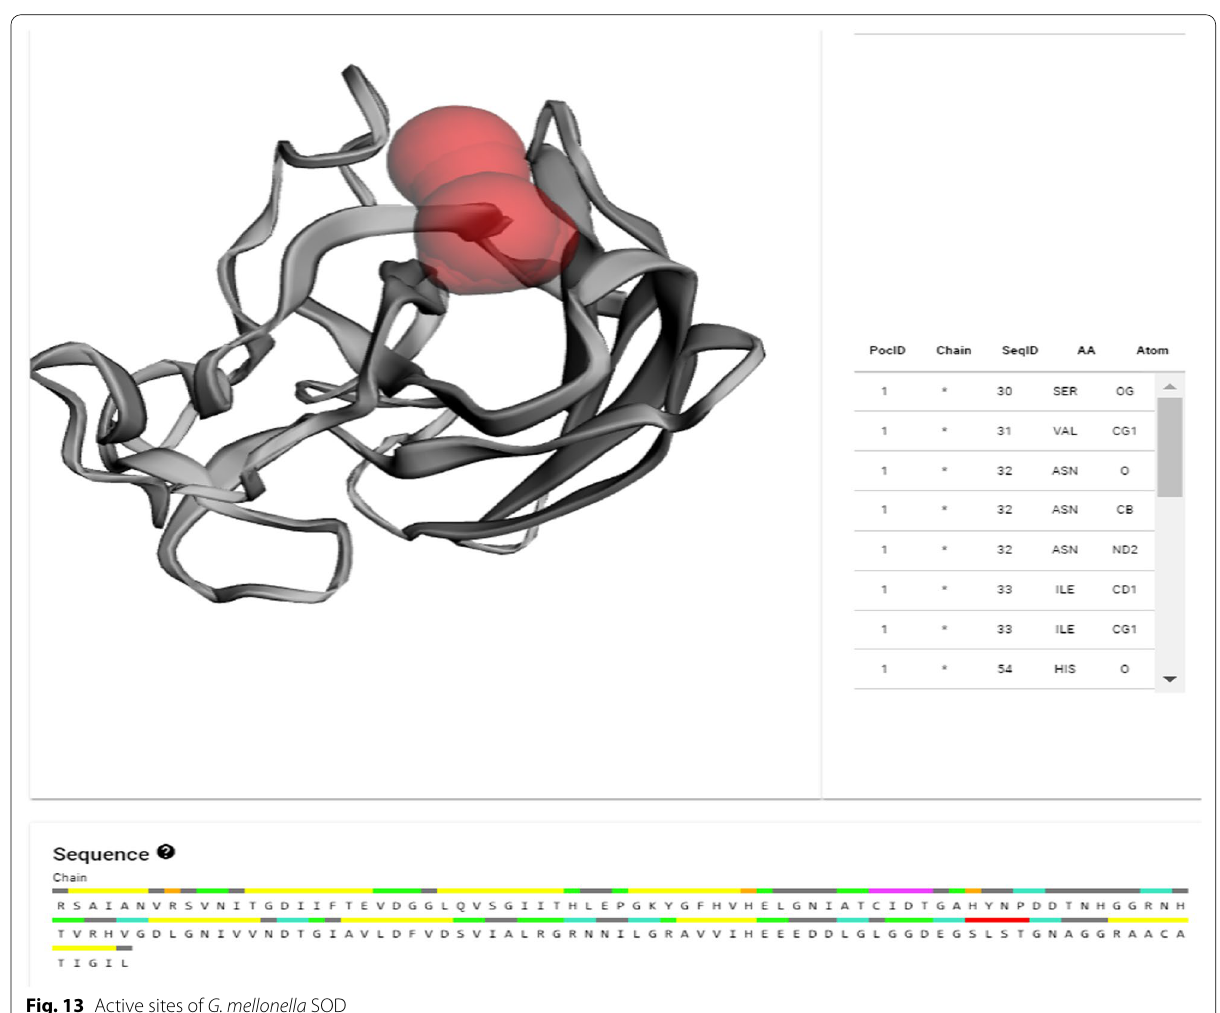
Fig. 13 Active sites of G. mellonella SOD